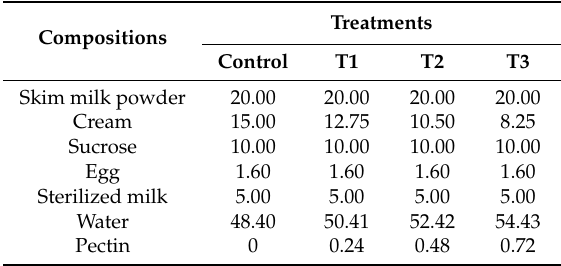
Table 4. Formulation of ice cream mixes (%, w / w